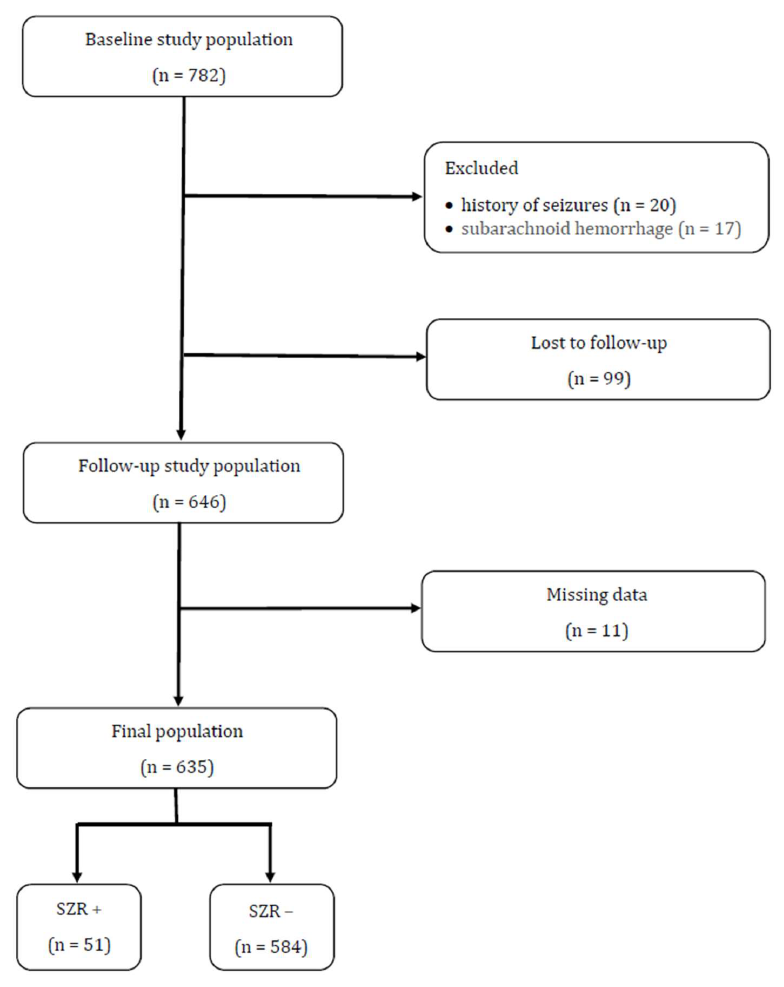
Figure 1. Study design. SZR +: patients with post-stroke seizures; SZR –: patients without post-stroke seizures.